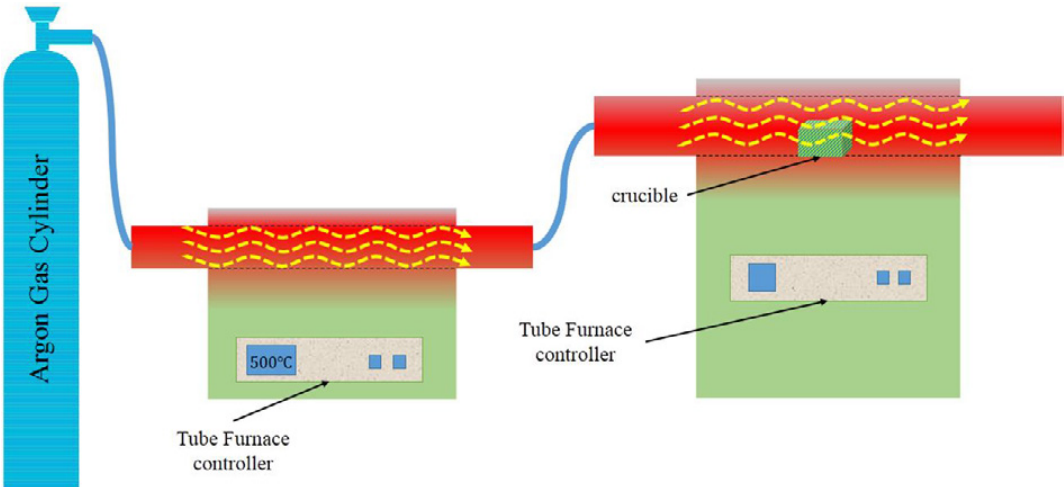
Fig. 3. The schematic of the process used in the test along with its configuration.